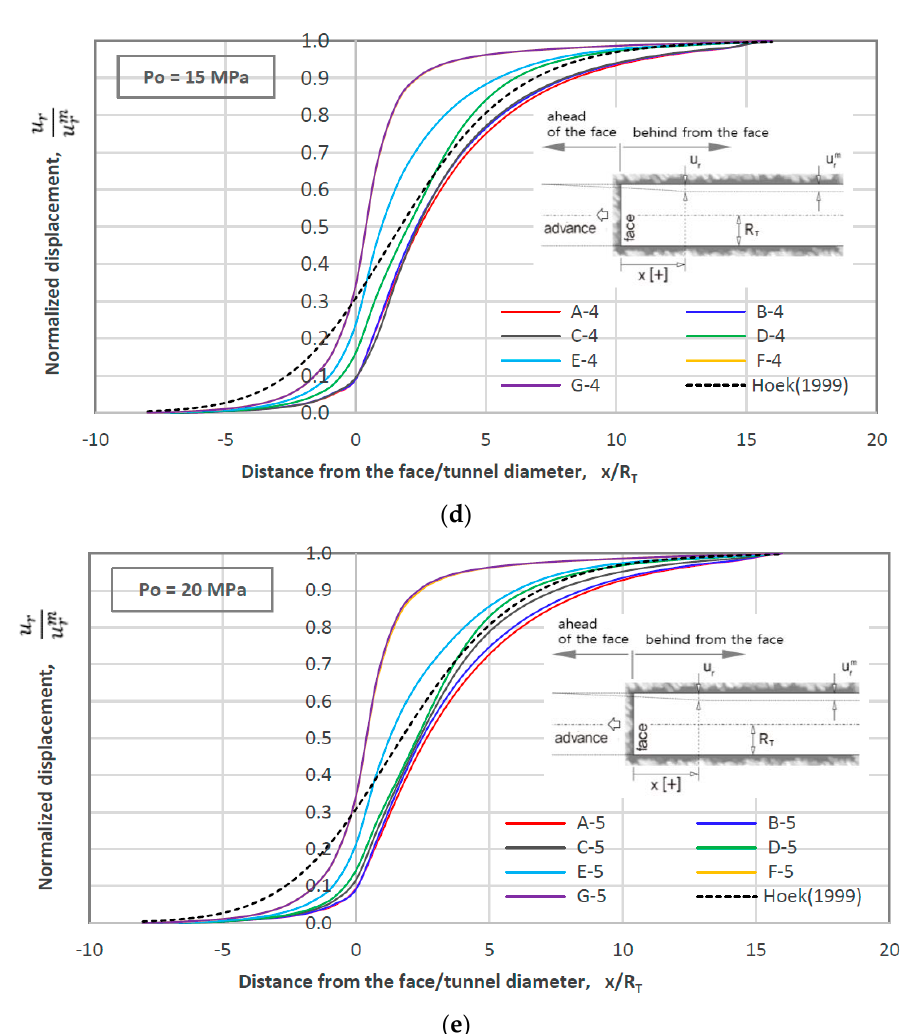
Figure 7. LDP results from 3D numerical analysis: ( a ) 𝑃 (cid:2868) = 3 MPa; ( b ) 𝑃 (cid:2868) = 5 MPa; ( c ) 𝑃 (cid:2868) = 10 MPa; ( d ) 𝑃 (cid:2868) = 15 MPa; and ( e ) 𝑃 (cid:2868) = 20 MPa.